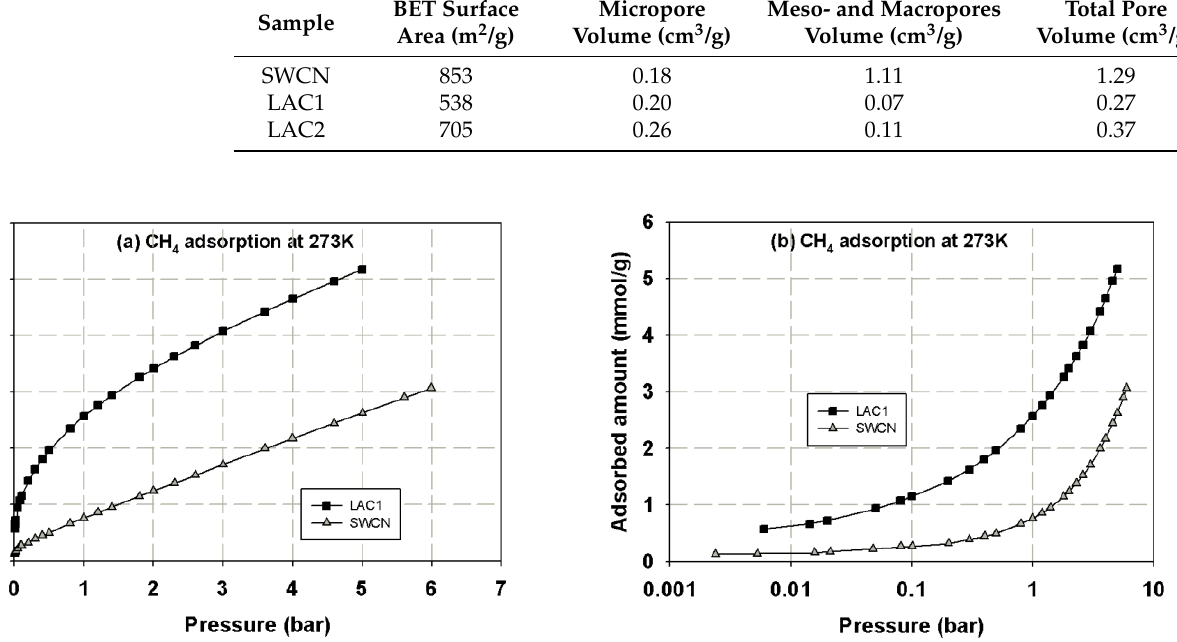
Figure 4. Adsorption isotherms of methane in activated carbons and single wall carbon nanotube at 300 K in linear ( a ) and semi-log ( b ) scales.